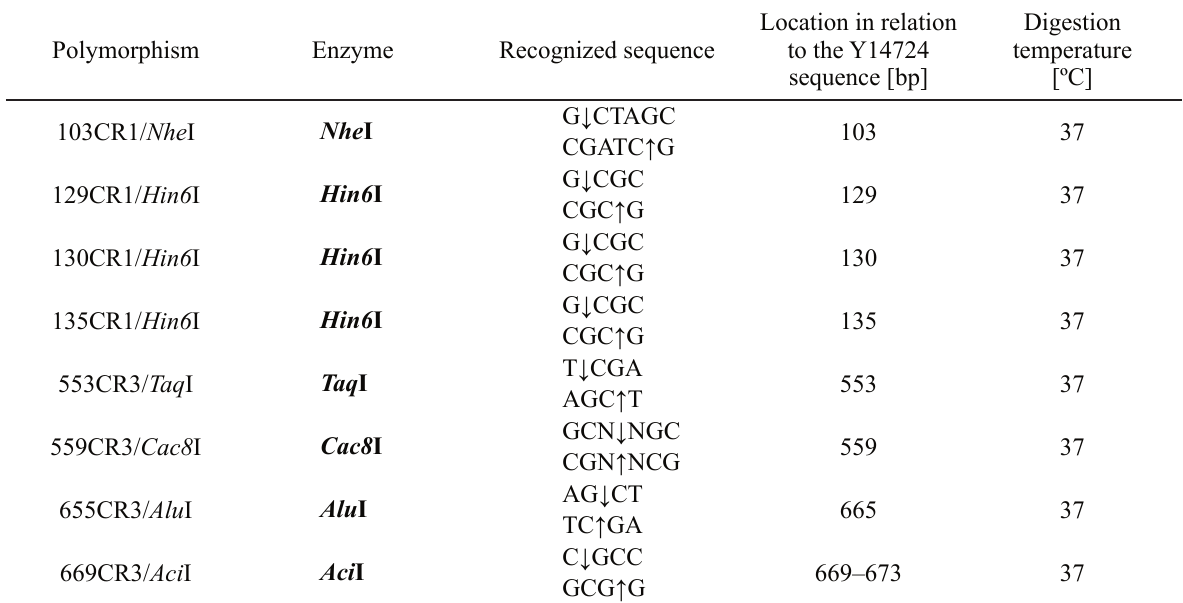
Restriction enzymes used to analyze the genetic diversity of the mtDNA control region by PCR-RFLP Polymorphism